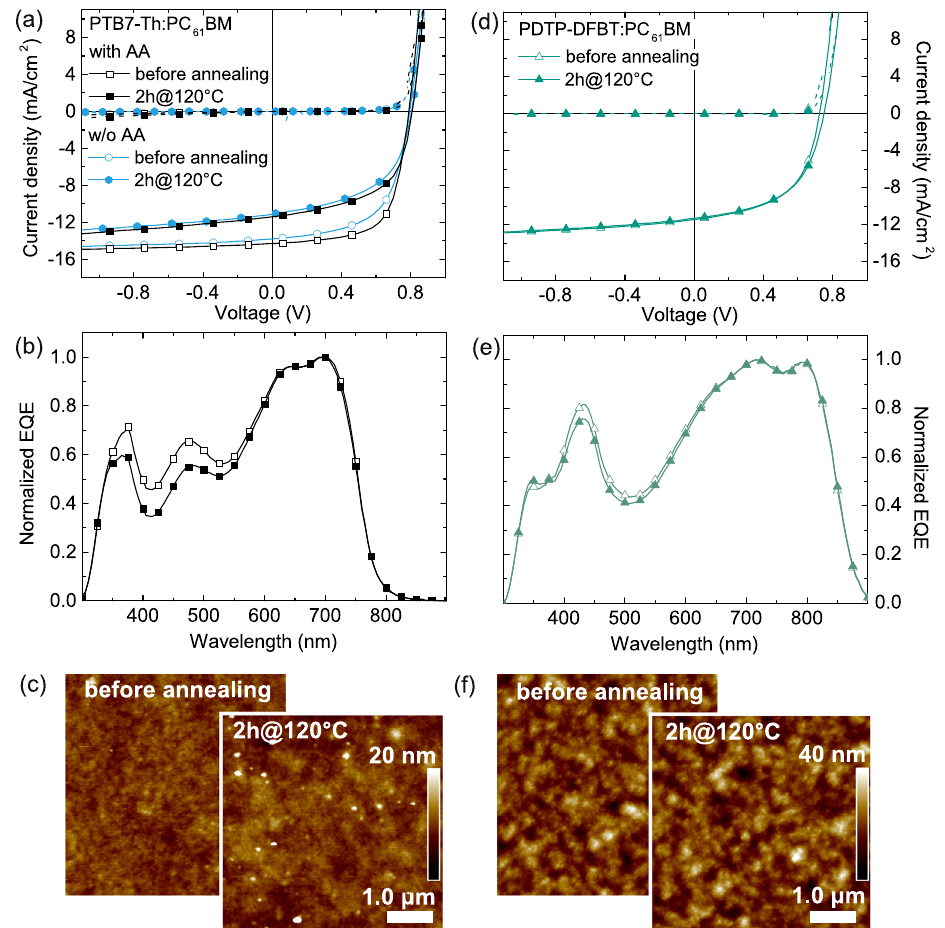
Fig. 2 a Typical J – V curves of binary PTB7-Th:PC 61 BM solar cells under AM1.5 illumination (solid lines) and in the dark (dashed lines), processed after adding 2% p -anisaldehyde (AA) to the stock solution (black) and processed omitting the co-solvent (blue). The samples were measured before annealing (open symbols) and after thermal annealing (120 °C, 2 h, closed symbols). b Corresponding normalized external quantum ef fi ciencies. 1 out of 5 data points is marked with a symbol to guide the eye. c Topography images of the binary PTB7-Th:PC 61 BM blends processed with AA before (back) and after annealing (front). d – f Same data set for solar cells comprising binary PDTP – DFBT:PC 61 BM absorber